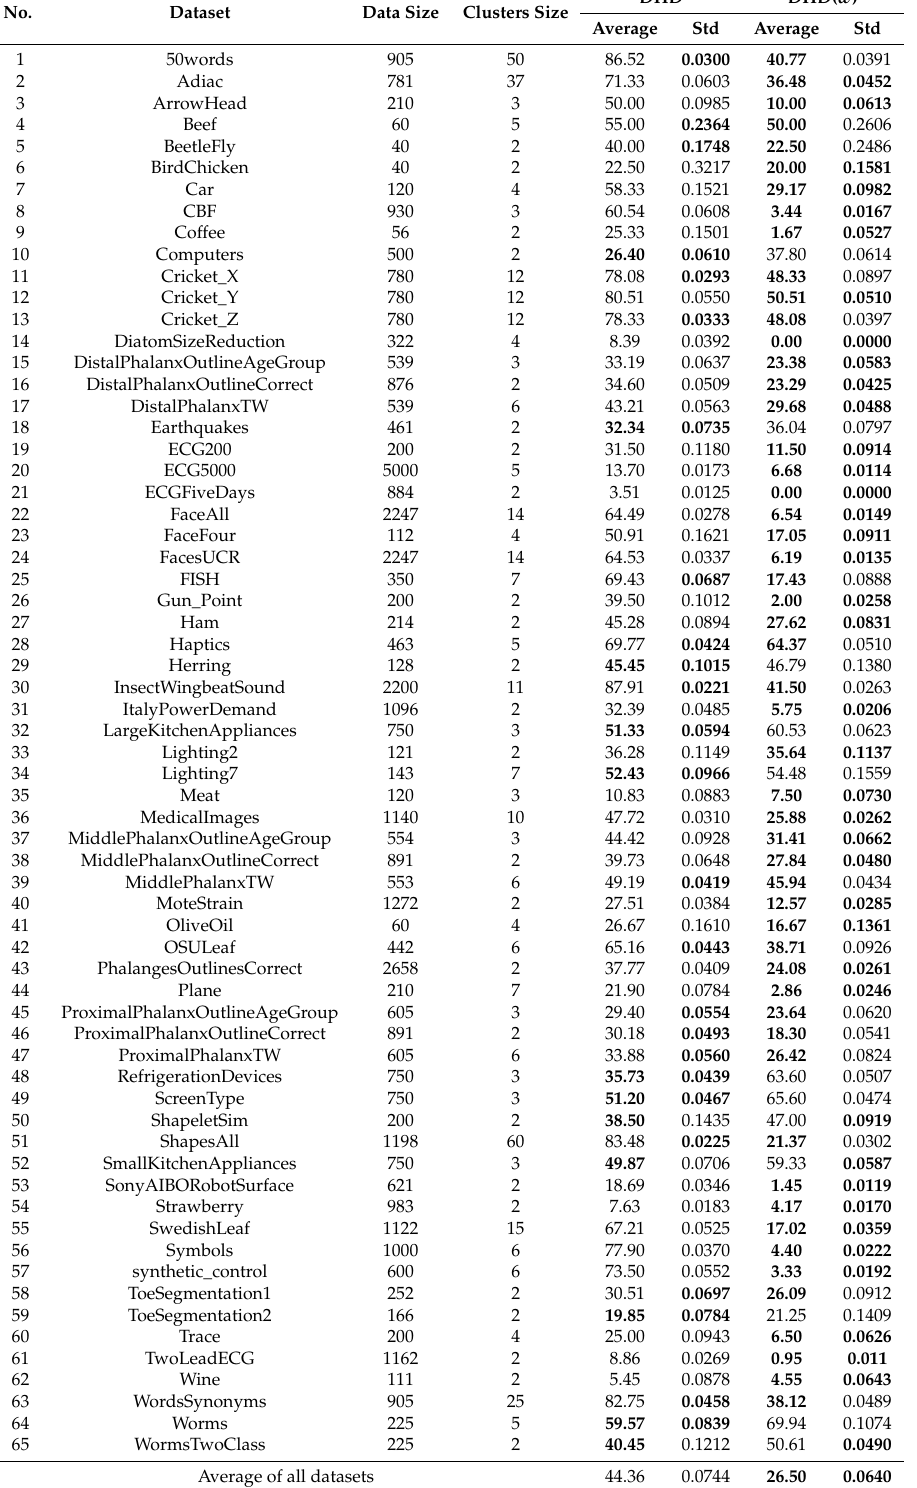
Table A1. Classification Error Ratio (%) on Time Series Datasets. The best performance of each dataset is in